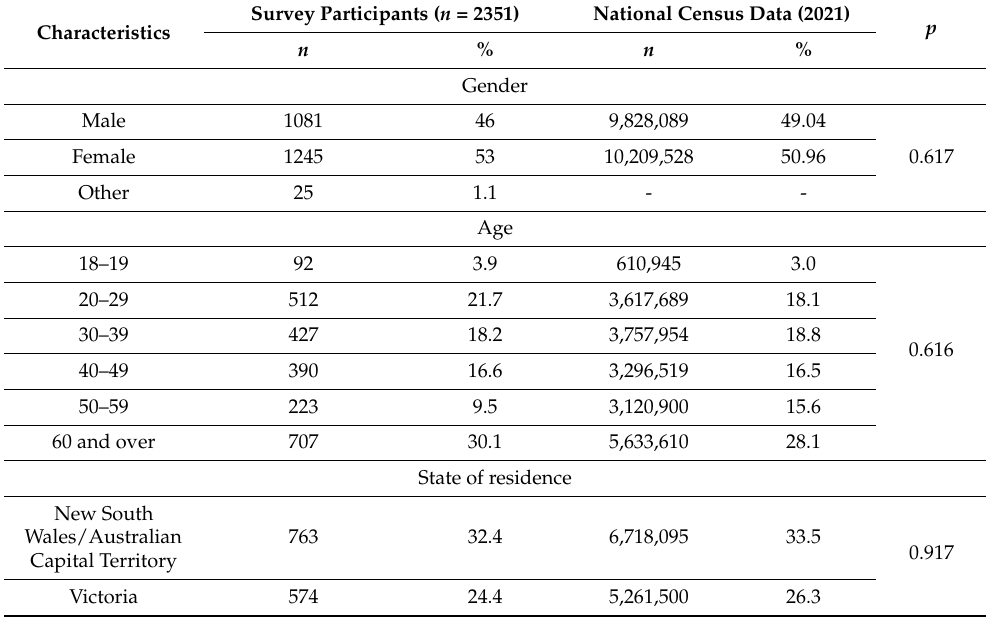
Table 1. Sociodemographic characteristics of survey participants ( n = 2351) compared with national data from the 2021 National